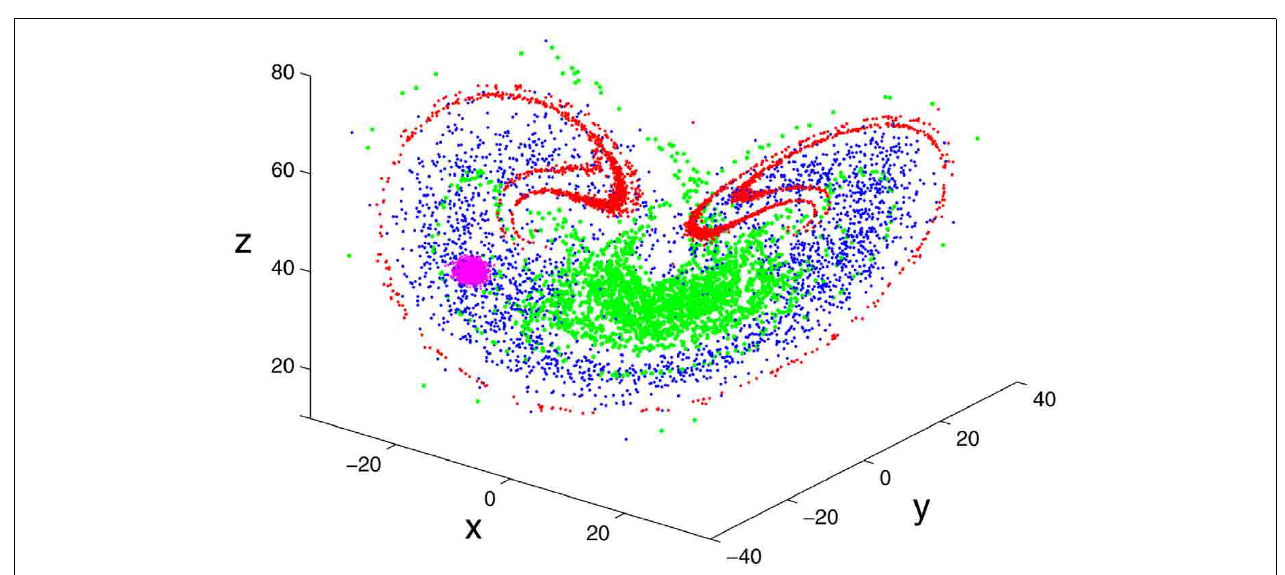
FIGURE 2 | Error growth in the chaotic Lorenz system (Lorenz, 1963) illustrated using an ensemble forecasting framework, where 2500 initial